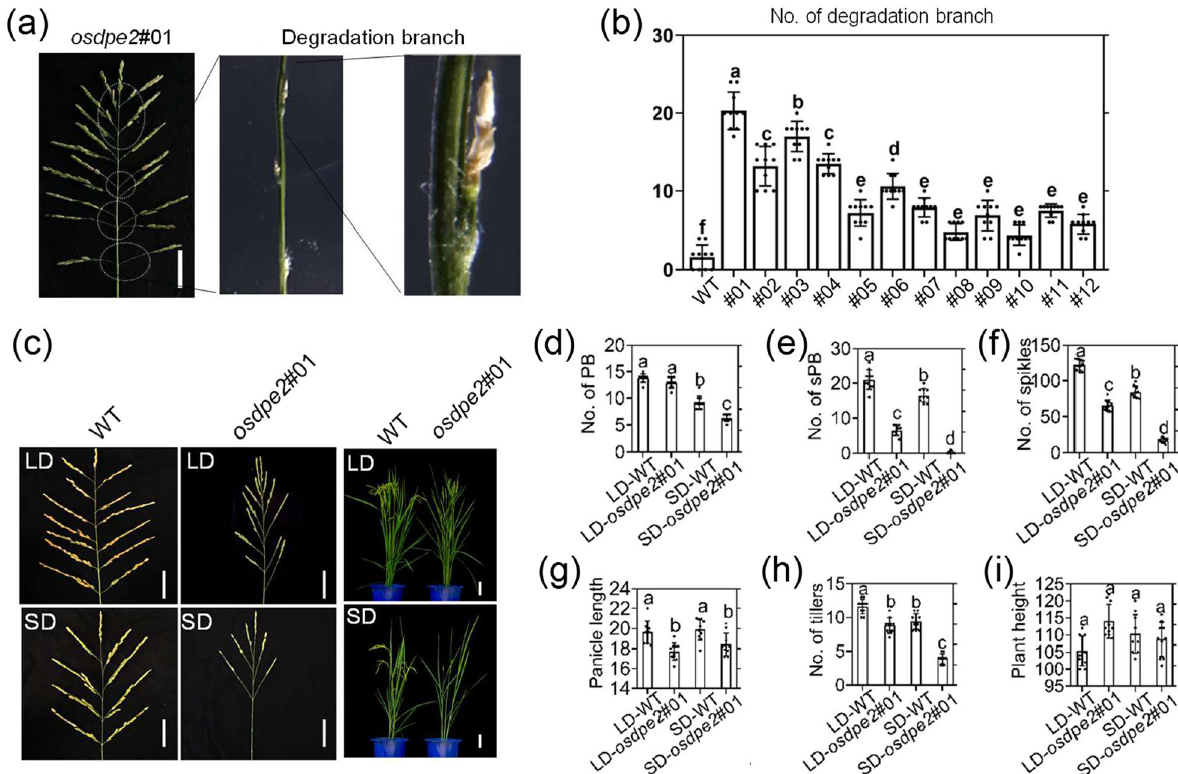
Fig. 4 OsDPE2 regulates panicle morphogenesis of rice. a Phenotypic characteristics of degradation branches in OsDPE2 mutants. b Number of degradation branches of WT and 12 allelic OsDPE2 mutants. c Comparative analysis of panicle and plant phenotypic characteristics. d – i Yield trait of WT and osdpe2#01 under LD and SD conditions. Scale bar of panicle